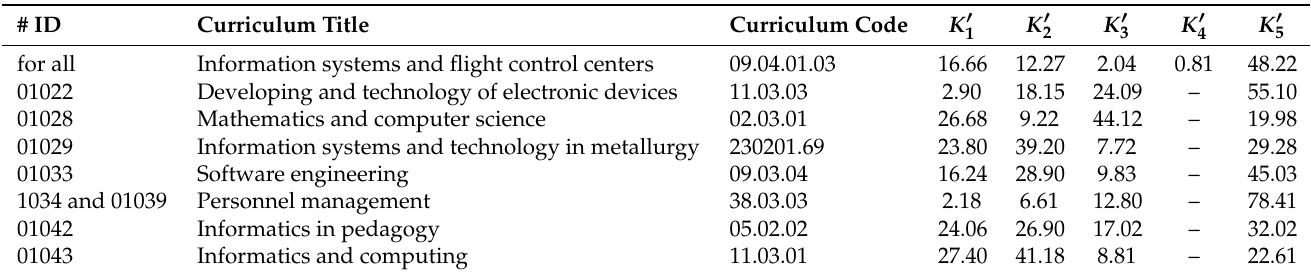
Table 3. Contribution of courses of different curricula to developing key professional skills for undergraduate and graduate